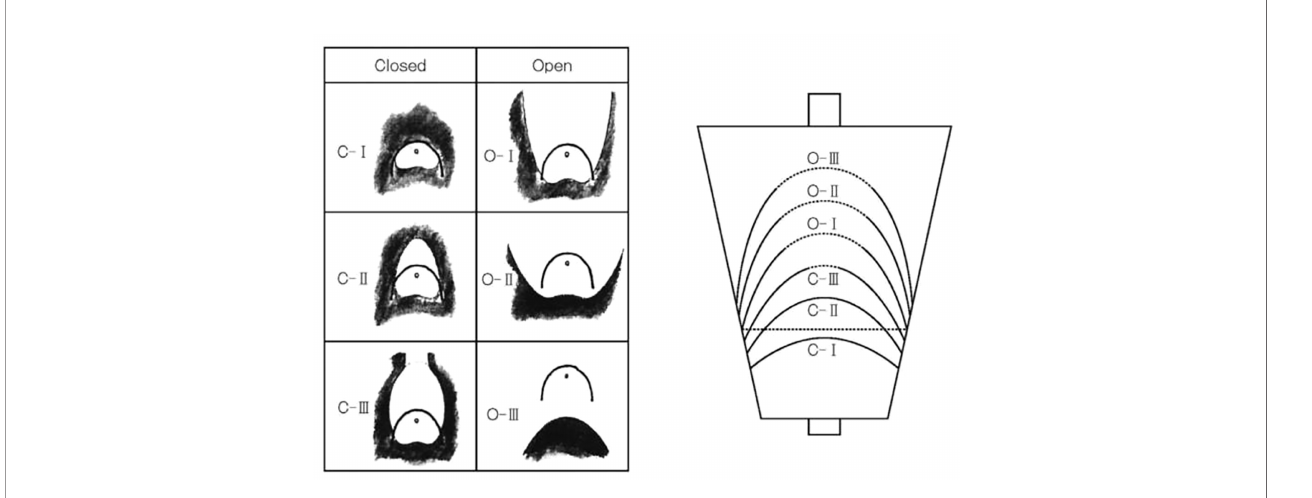
FIGURE 1 | Kimura-Takemoto classi fi cation of endoscopic gastric mucosal atrophy. Reproduced with permission of the publishers from